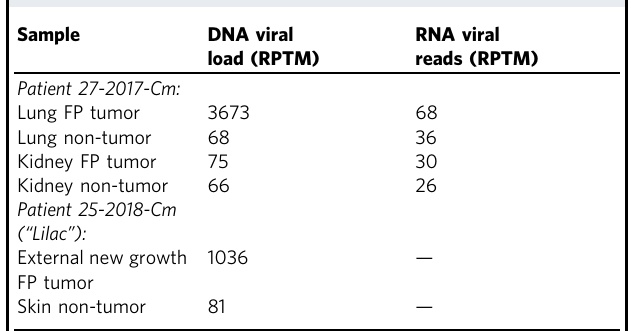
Table 2 Comparison of viral sequencing reads per tumor and non-tumor tissue at the DNA and RNA level, for patients 27- 2017-Cm and 25-2018-Cm “ Lilac ”